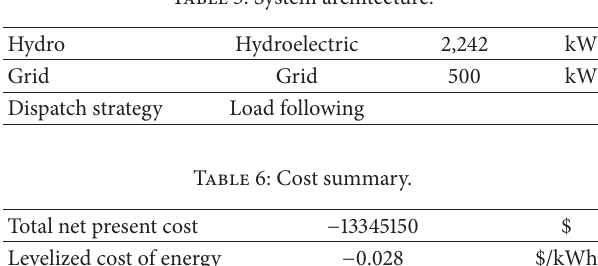
Figure 16: Cumulative cash flow of the project with RETscreen simulation software. Table 5: System architecture.